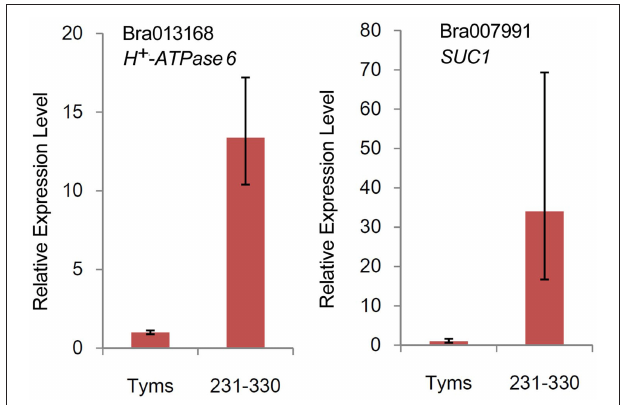
FIGURE 7 | Relative expression levels of two target genes revealed by